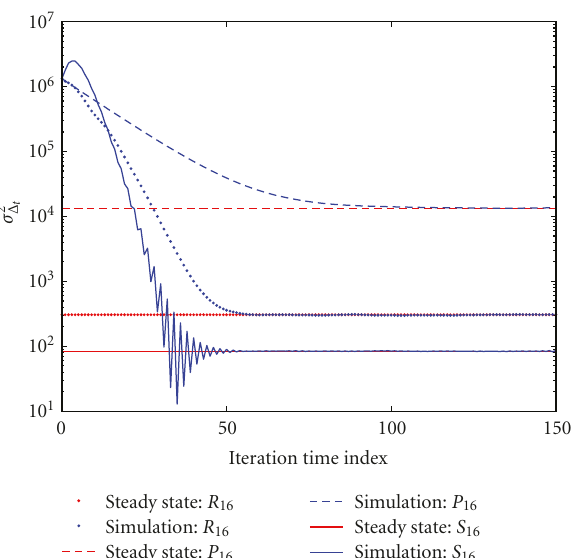
Figure 6: σ 2 as a function of the number of nodes for the SO-DCTS Δ t algorithm in structured networks with Gaussian delay.